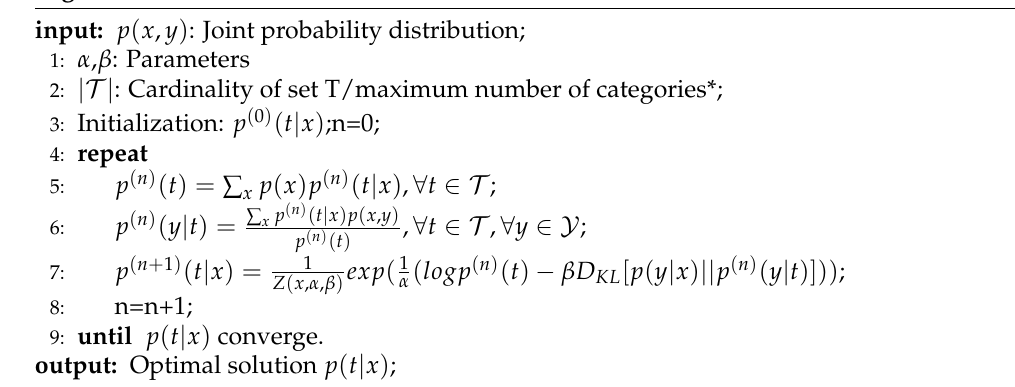
Algorithm A1 The elastic information bottleneck